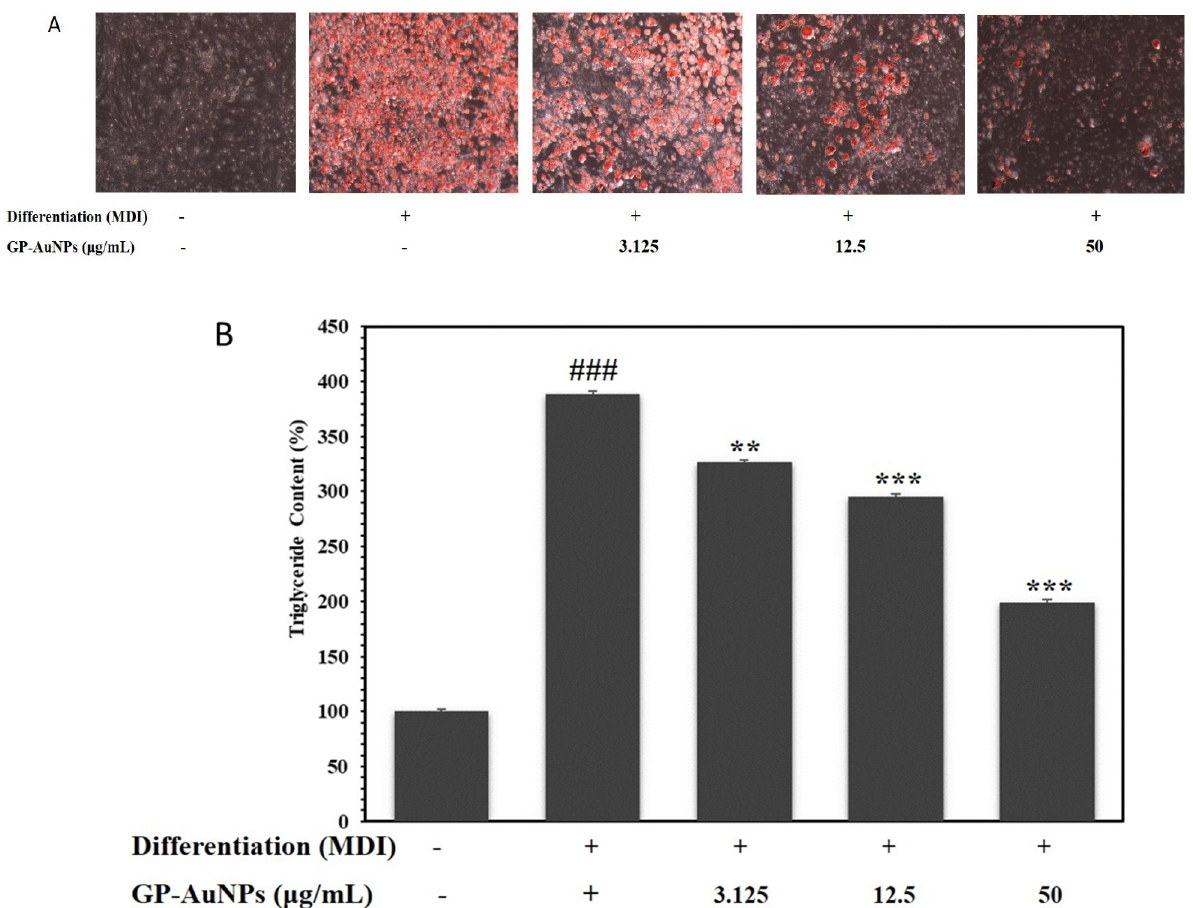
Figure 7. Inhibitory effect of the lipid accumulation for GP-AuNPs on MDI-induced 3T3-L1 adipocytes. ( A ) Fat droplets were measured by oil red O staining and observed using a micro- scope (at × 40). ( B ) The absorbance of lipid accumulation, which was oil red O dye, was dissolved in isopropyl alcohol (520 nm). The data are mean values of three experiments ± SEM; ### <0.001 compared with control, ** p < 0.01, *** p < 0.001 compared with the MDI.